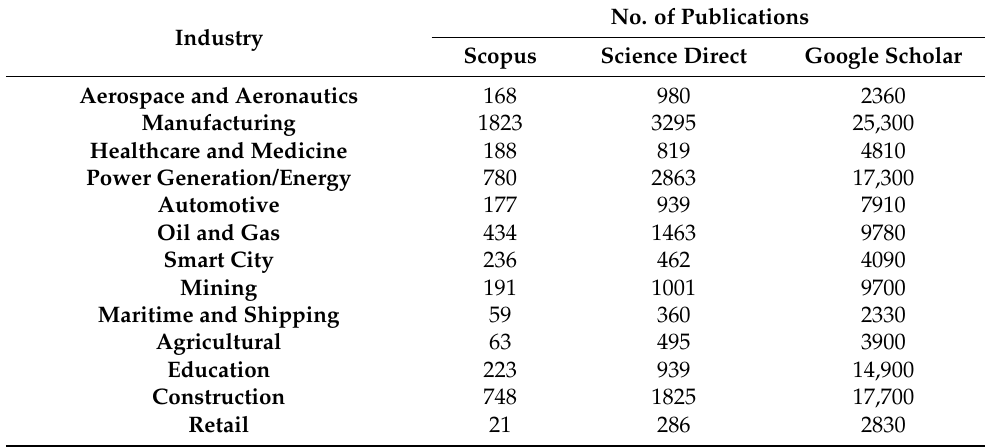
Table 1. Number of Digital Twin-related publications in each industry based on different platforms.